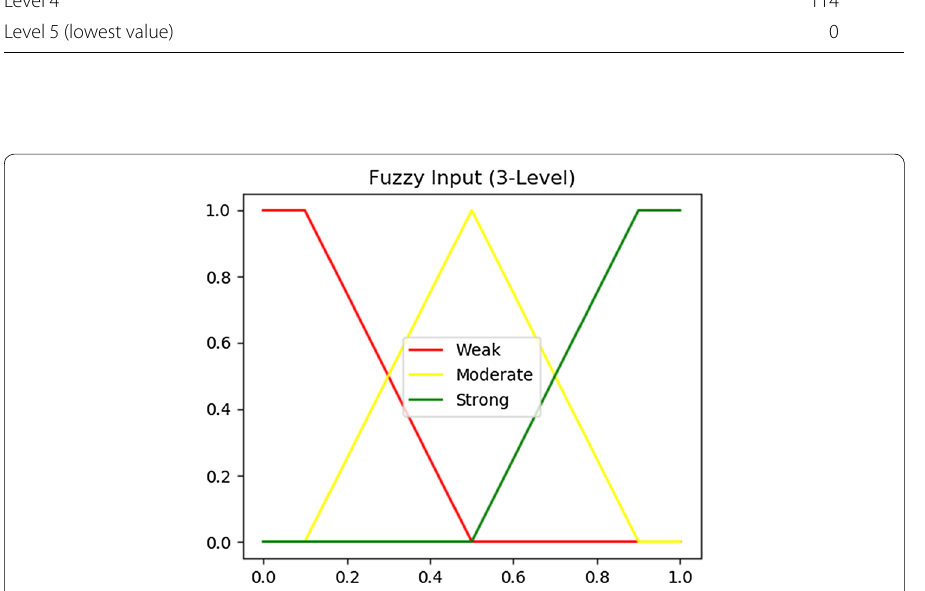
Fig. 10 Membership function for 3-level input membership